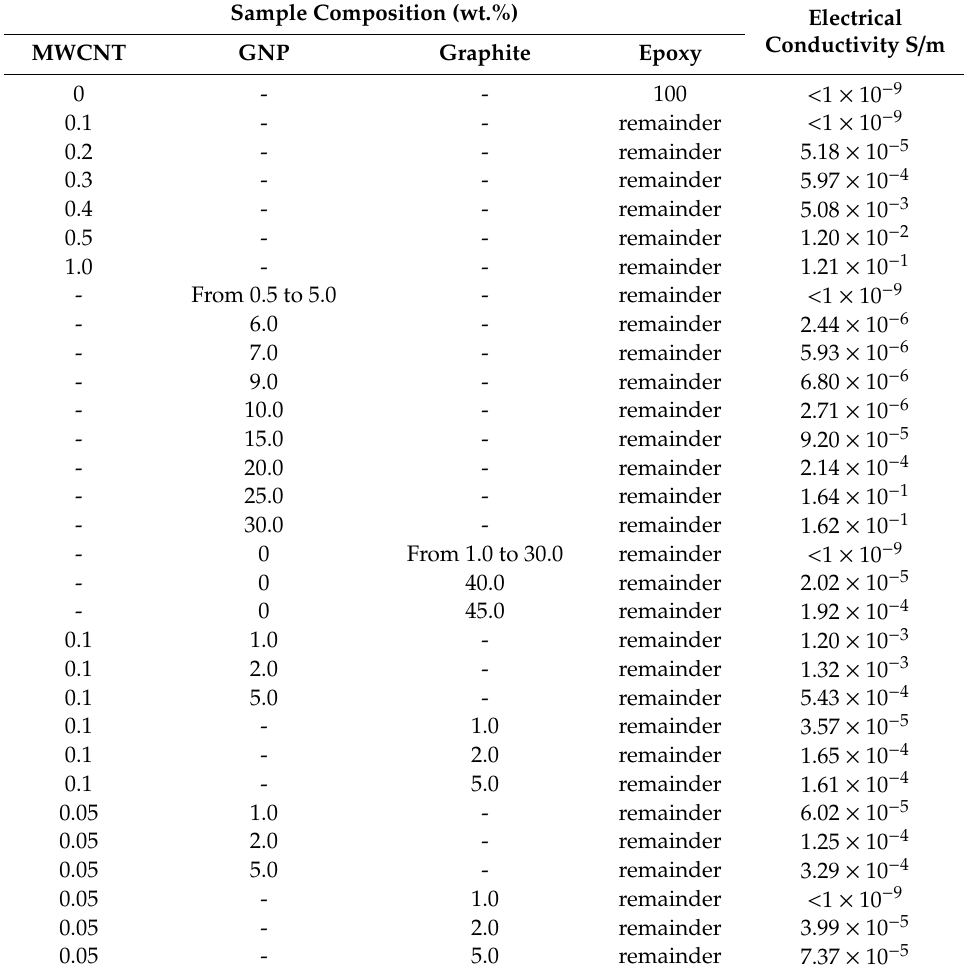
Table 3. Electrical conductivity of the two-components and the hybrid (three components) epoxy-based composites. Sample Composition